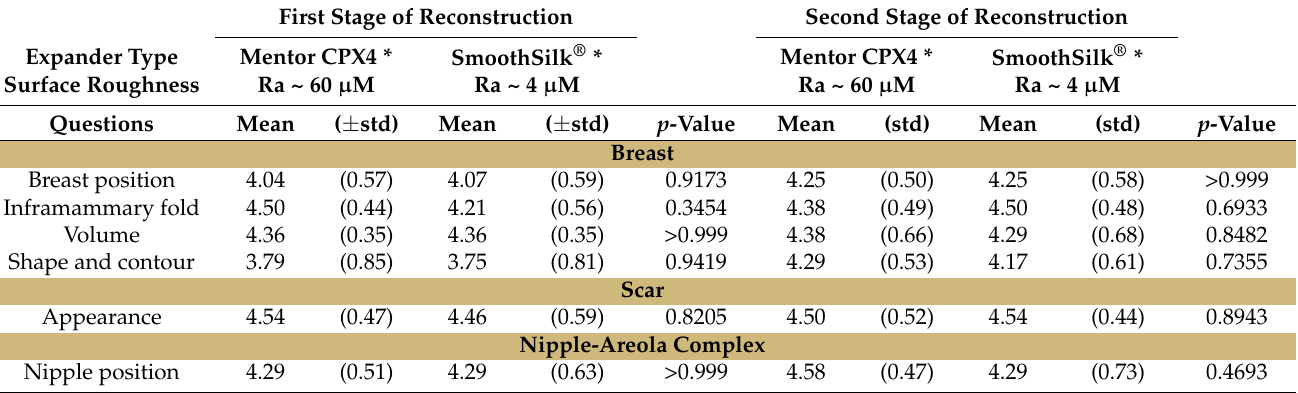
Table 7. Aesthetic evaluation of Mentor CPX ® 4 and SmoothSilk ® expander devices after the first and second stages of reconstruction.